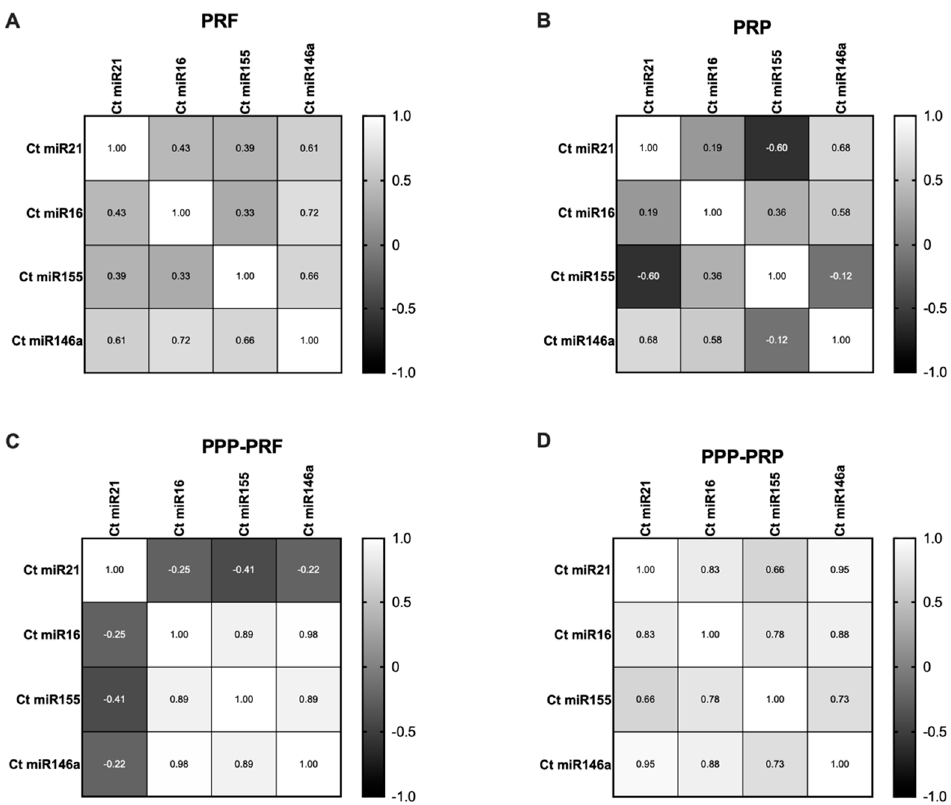
Figure 5. Representation of Spearman r correlation test variety among different autologous blood products. The Ct value of other miRNAs in PRF ( A ), PRP ( B ), PPP-PRF ( C ), and PPP-PRP ( D ) was compared.